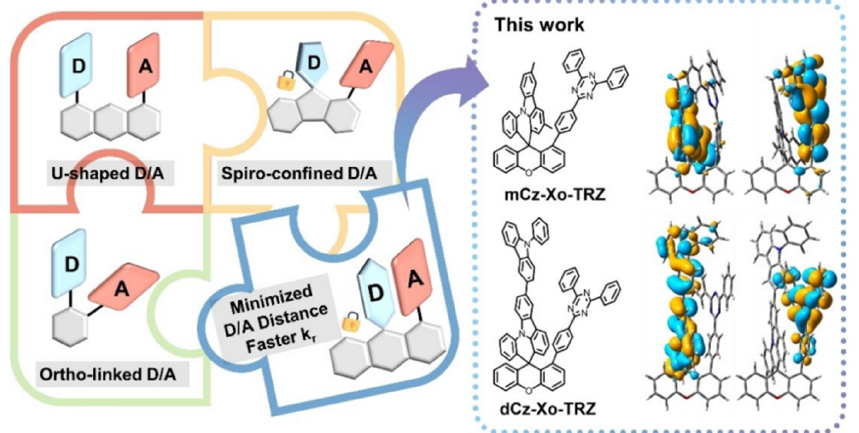
Figure 6. TSCT-TADF molecules with different types of donor–acceptor alignments, and molecular structures of mCz-Xo-TRZ and dCz-Xo-TRZ with their HOMO/LUMO distribution. Reproduced with permission from Tianyu Huang, Qi Wang, Guoyun Meng et al., “Accelerating Radiative Decay in Blue Through-Space Charge Transfer Emitters by Minimizing the Face-to-Face Donor–Acceptor Distances”; published by John Wiley and Sons , 2022 [39].